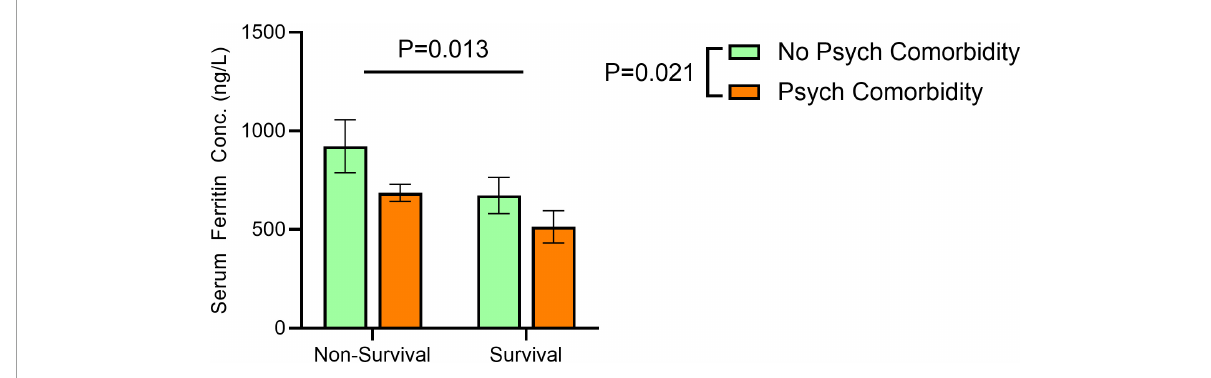
FIGURE2 Effects of non-survival and comorbid psychiatric conditions on serum ferritin concentrations. Significant effects for non-survival [ F (1,620) = 6.080, P = 0.013] and psychiatric comorbidity [ F (1, 620) = 5.33, P = 0.02] on serum ferritin, but no interaction between the two factors [ F (1,620) = 0.2047, P = 0.6 on serum ferritin concentration correcting for age at time of SARS-CoV-2 positive test by two-way ANOVA. Error bars represent 95% confidence